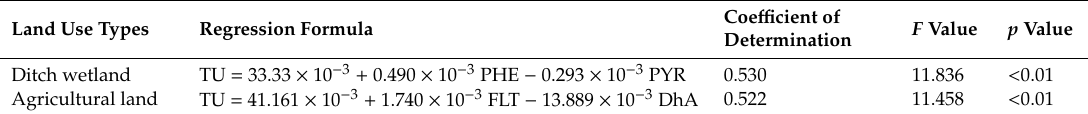
Table 7. Multiple linear stepwise regression analysis between toxic units (TUs) and the concentration of PAHs in two land